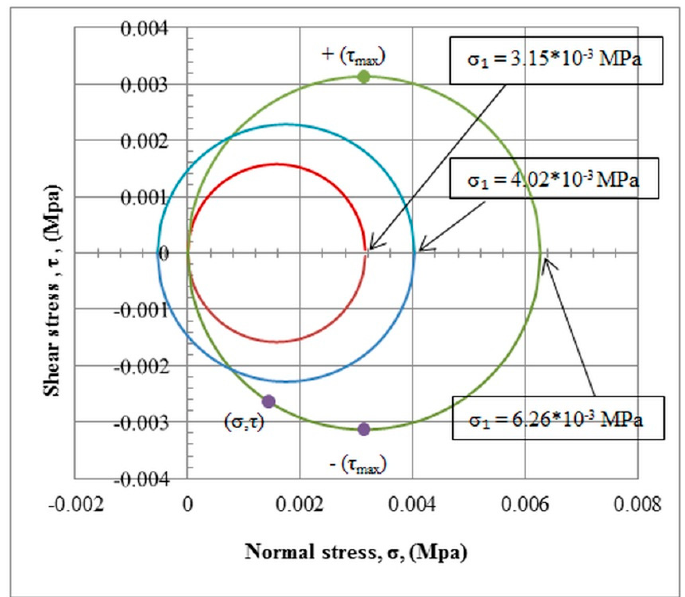
Figure 10. Mohr’s circles for the subgrade layer of the track